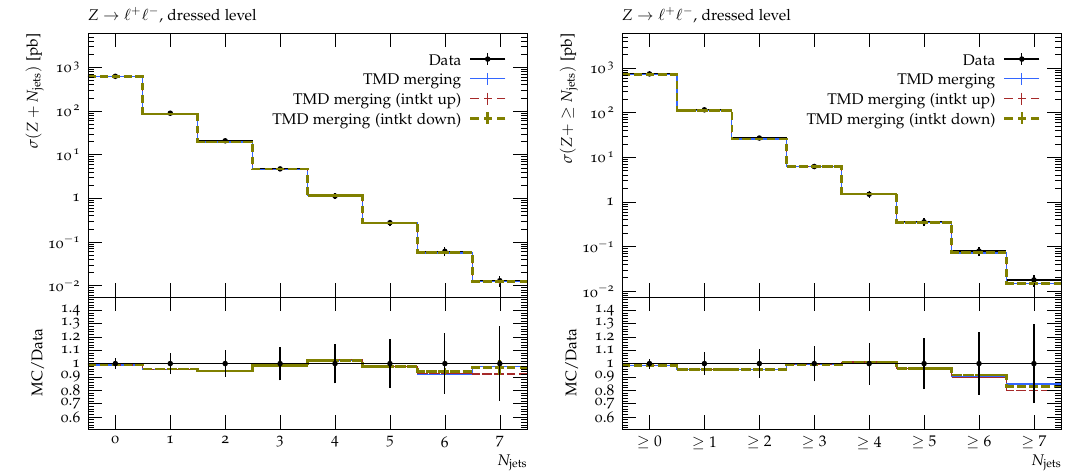
Figure 28 . Exclusive (left) and inclusive (right) jet multiplicity distributions in Z +jets: intrinsic- k T sensitivity.